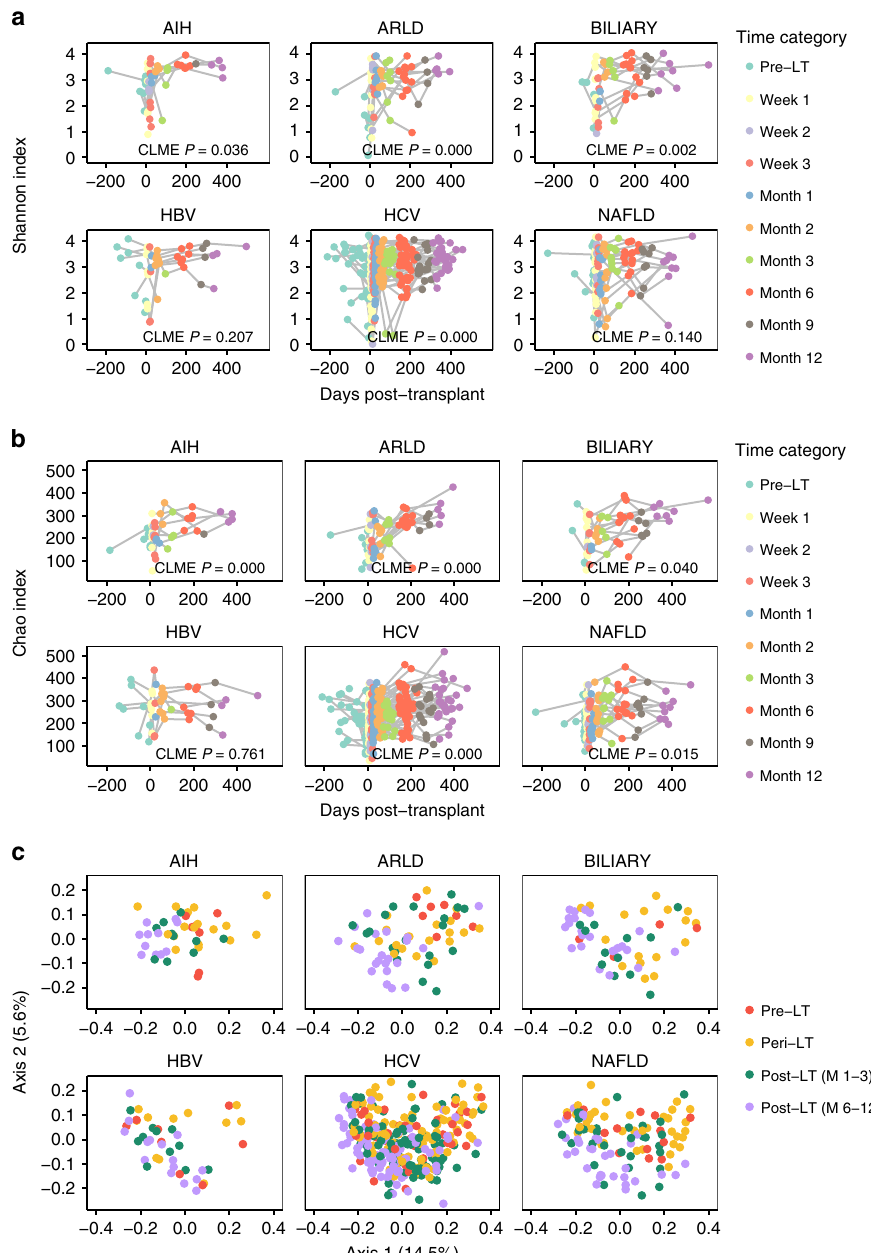
Fig. 3 Progression of gut microbiome diversity before and after transplantation strati fi ed by the underlying liver disease. Shannon ( a ) and Chao ( b ) α - diversity and UniFrac β -diversity ( c ) throughout the study period are shown. a , b AIH (13 patients, 45 samples), ARLD (19 patients, 69 samples), BILIARY (18 patients, 58 samples), HBV (10 patients, 45 samples), HCV (71 patients, 304 samples), and NAFLD (30 patients, 115 samples) were the most represented indications for LT in our cohort. These panels show Shannon ( a ) and Chao ( b ) α -diversity within each sample by the number of days post-LT